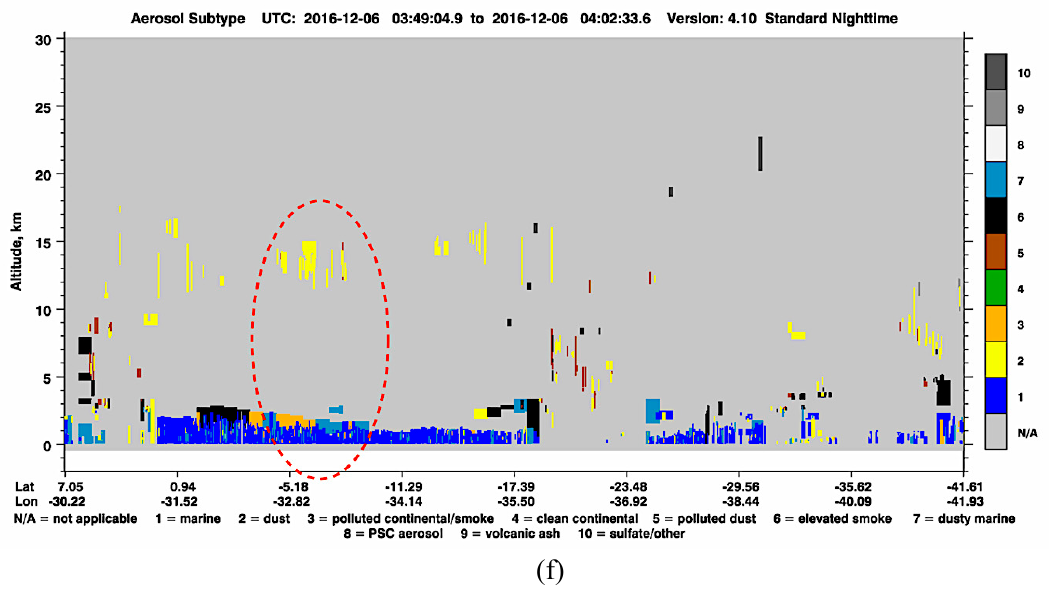
Figure 9. Case study CS-2 on 6 December 2016. ( a ) Backscatter profile at 355nm ( a ), 532 nm, and ( b ) 1064 nm ( c ) from DUSTER / LIDAR; ( d ) Backscatter profiles at 532 nm from CALIOP / LIDAR; ( e ) 7-day simulations of the backwards trajectories from HYSPLIT; ( f ) aerosol subtype from CALIPSO, displaying the (1) marine (in blue), (2) dust (in yellow), (3) polluted continental / smoke (in orange), (4) clean continental (in green), (5) polluted dust (in brown), (6) elevated smoke (in black), (7) dusty marine (in light blue), (8) PSC (in white), (9) volcanic ash (in gray), (10) sulfate / other (in dark gray) aerosols.